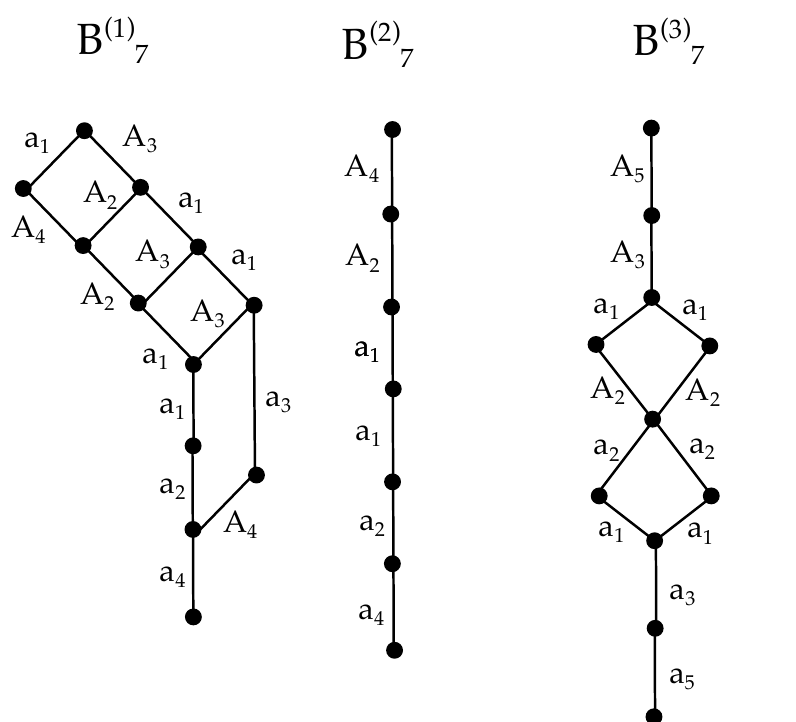
Figure 30 . The Hasse diagrams for B (1) whereas a n are the standard SU( n + 1)